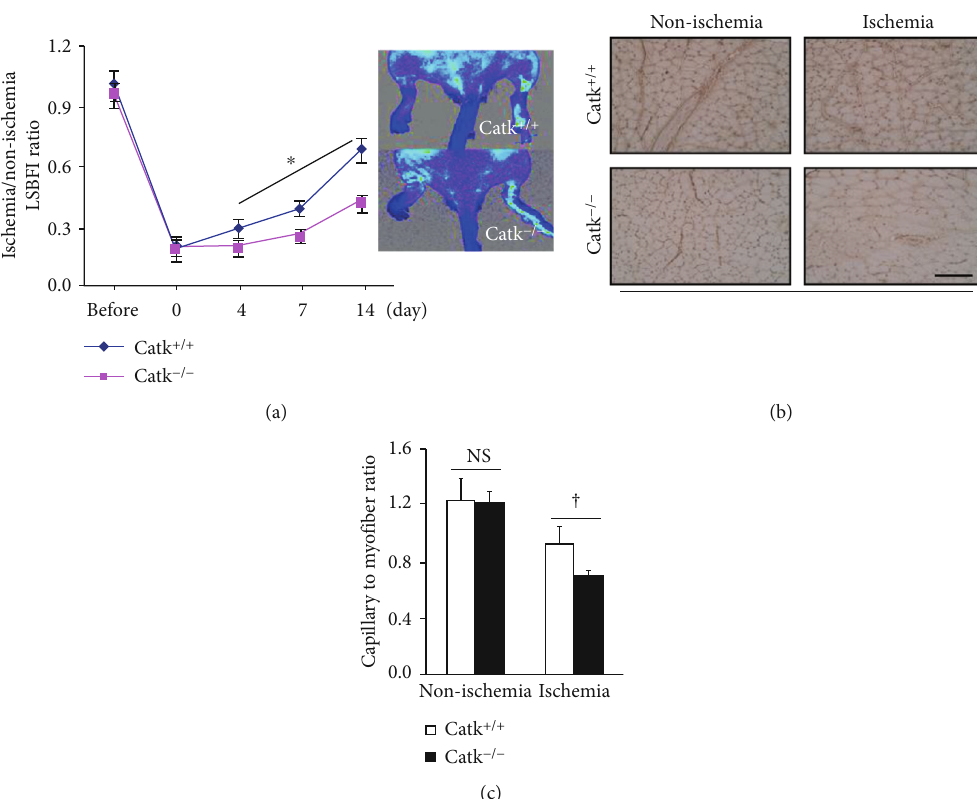
Figure 5: CatK de fi ciency impaired the blood fl ow recovery and capillary formation in ischemic muscles of aged mice. (a) Representative LSBFI results and quantitative data show the ratio of ischemia to nonischemia blood fl ow in the aged CatK +/+ and CatK − / − mice. (b, c) Representative images and quantitative data show the capillary density in nonischemic and ischemic thigh adductor muscles. ∗ p < 0 : 05 , † p < 0 : 01 , vs. corresponding controls (days 4, 7, and 14) by two-way repeated-measures ANOVA and Bonferroni post hoc tests or one- way ANOVA and Tukey ’ s post hoc tests. Scale bar, 50 μ m.